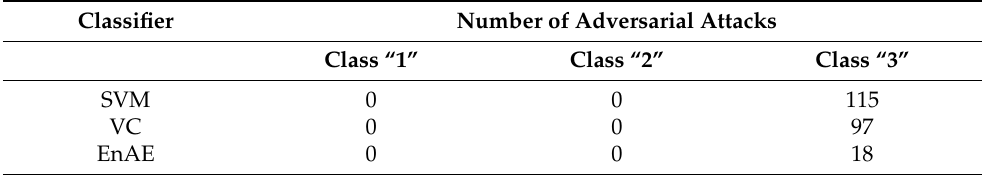
Table 7. Number of successful adversarial attacks against SVM, VC and EnAE. Classifier Number of Adversarial Attacks